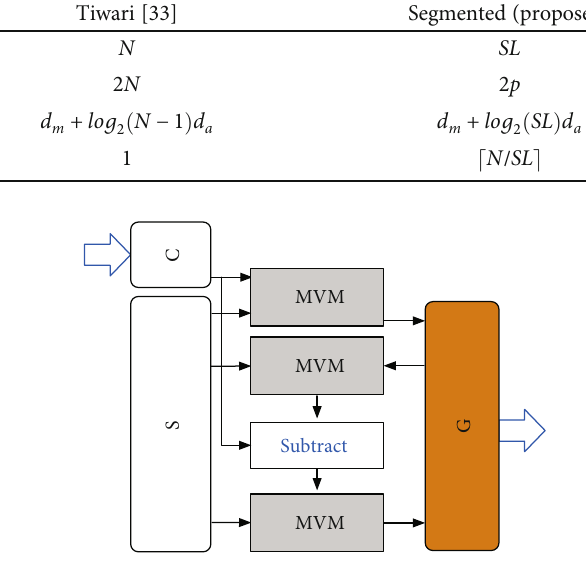
Figure 6: iLBP Architecture using Segment-based